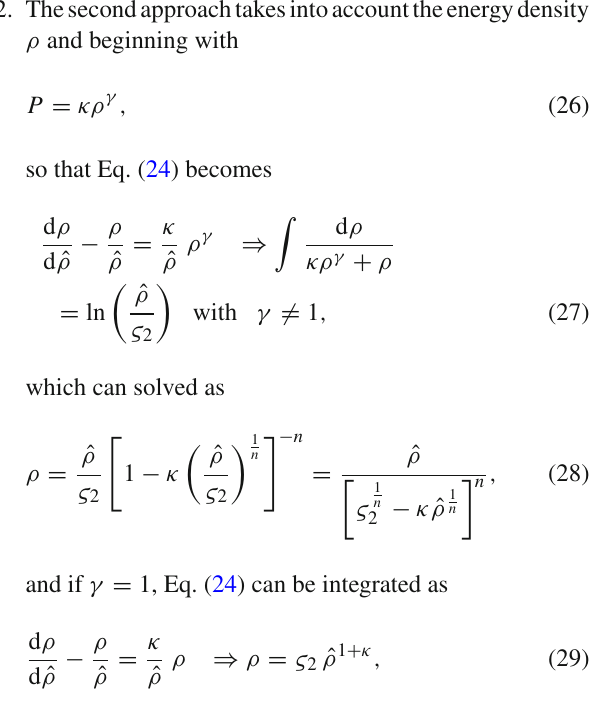
Fig. 9 Left: perturbed hydrostatic equilibrium equation as a function of ¯ ξ for the Lane–Emden master equation, showing the distribution of the net force immediately after it departures from equilibrium, for mod- els with parameters α = − 0 . 01, (cid:18) = 0 . 17, n = 0 . 75, C = 0 . 05 and several values of σ . Models that present cracking also unfulfill causality